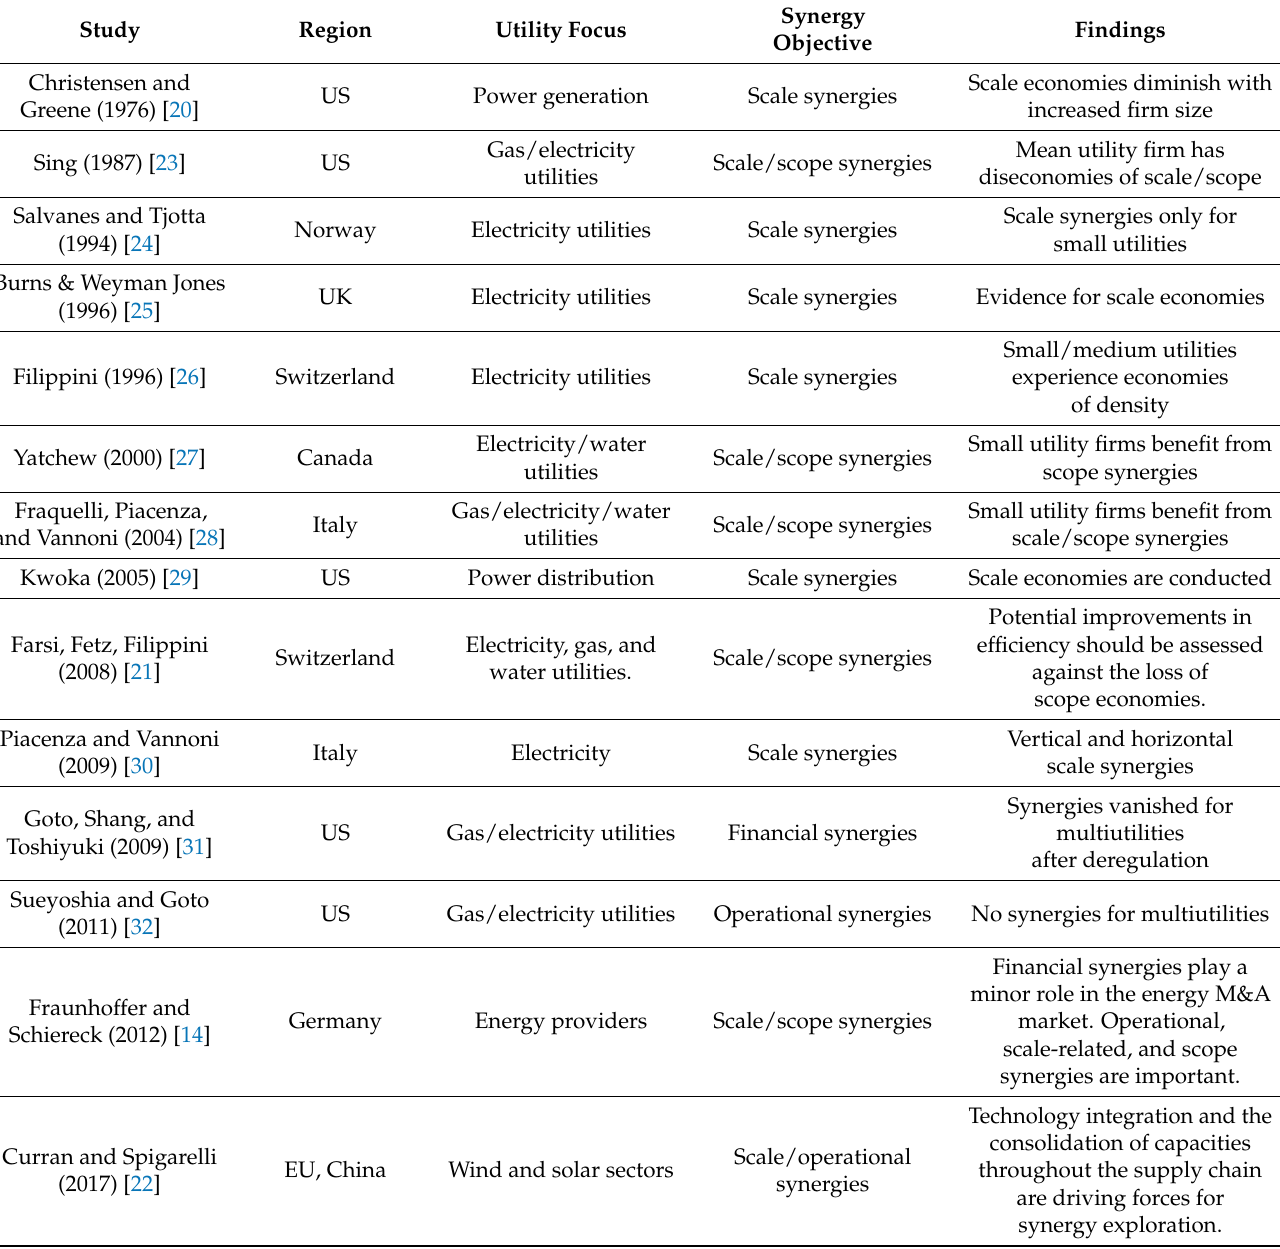
Table 2. Energy sector synergies for certain energy-related merger and acquisition (M&A)